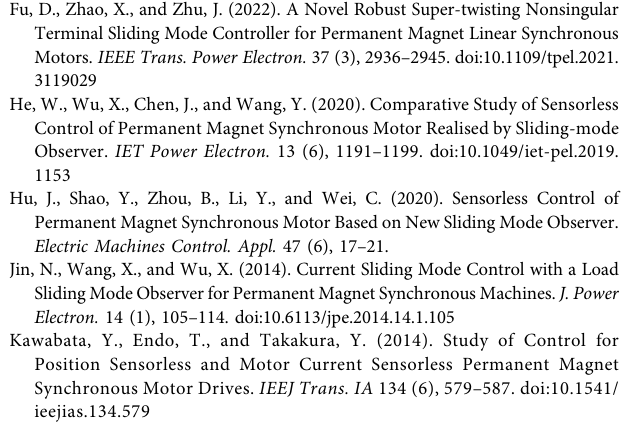
Figure 10 is the motor rotor position error curve. The maximum position error obtained by the traditional SMO shown in Figure 10A is 6.1 rad/min, while after the introduction of PLL, the maximum error between the actual position and the estimated position of the motor is .75 rad/min. It shows that the accuracy based on SMO with PLL is improved.